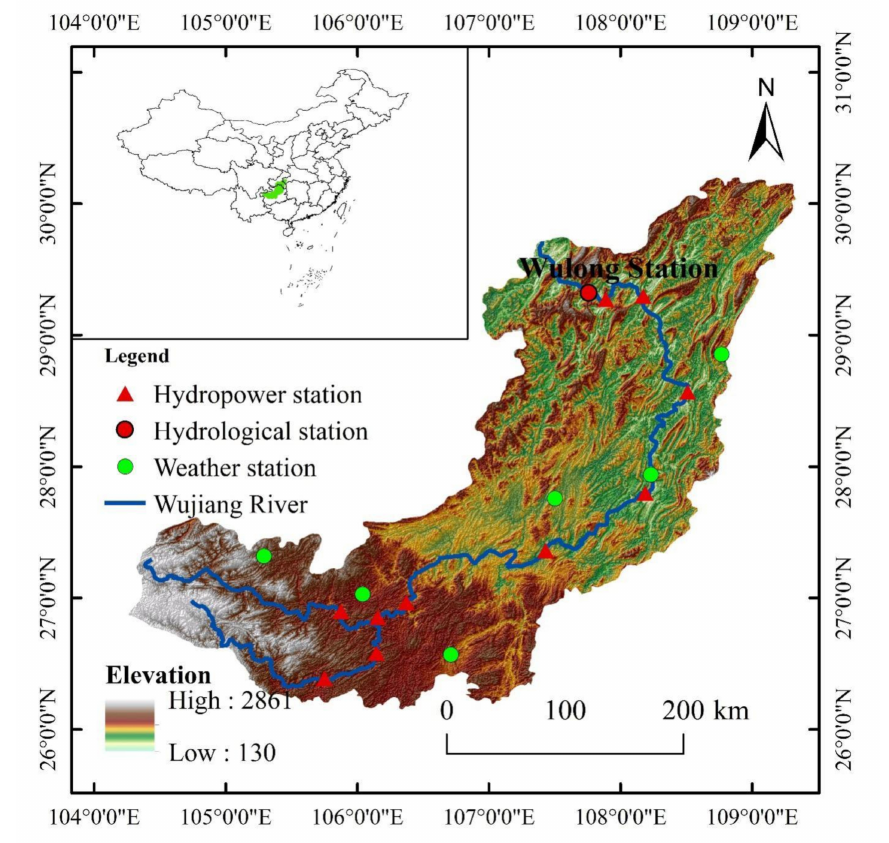
Figure 1. Location of the Wujiang River